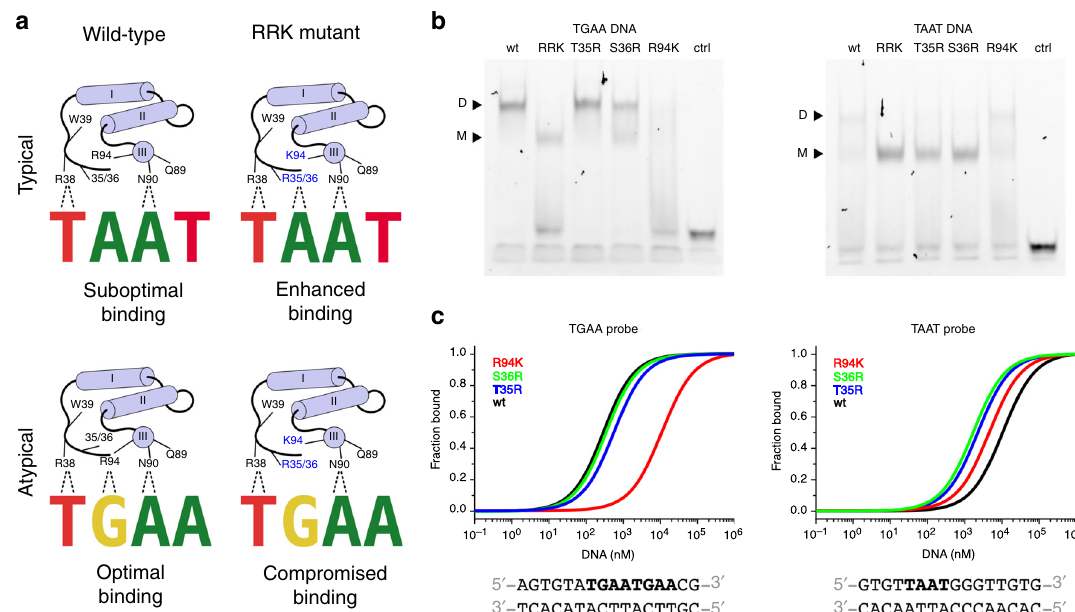
Fig. 6 Altered DNA speci fi city of the WUS-HD. a Schematic representation showing the sequence speci fi city of WUS-HD wild-type (left) and the RRK mutant (right) for typical TAAT (top panel) and atypical TGAA recognition motifs (bottom panel). Hydrogen bond interactions involved in base- recognition are highlighted (dashed lines) and relevant residues are indicated. Altered residues in the RRK mutant are shown in blue. b Electrophoretic mobility shift assays (EMSAs) of altered DNA speci fi city of WUS-HD for TGAA (left) and TAAT (right) probes. Monomer (M) and dimer (D) bound forms of WUS are indicated and the tested construct is given on top of the gel. c Quanti fi cation of WUS-HD DNA-binding af fi nity for TGAA (left) and TAAT (right) DNA by MST for the single point mutants T35R (blue), S36R (green), and R94K (red). As a reference the DNA-binding af fi nity of WUS-HD wt is shown in